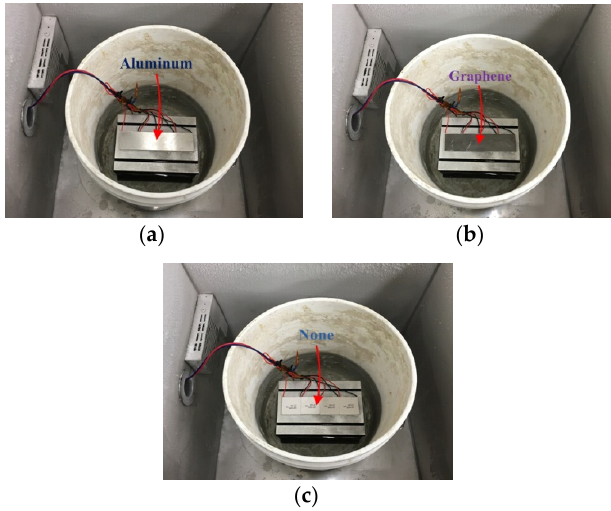
Figure 7. Photographs of the prototype of TE board power generation system with different thermally conductive materials, ( a ) Air; ( b ) Aluminum; and ( c ) Graphene.